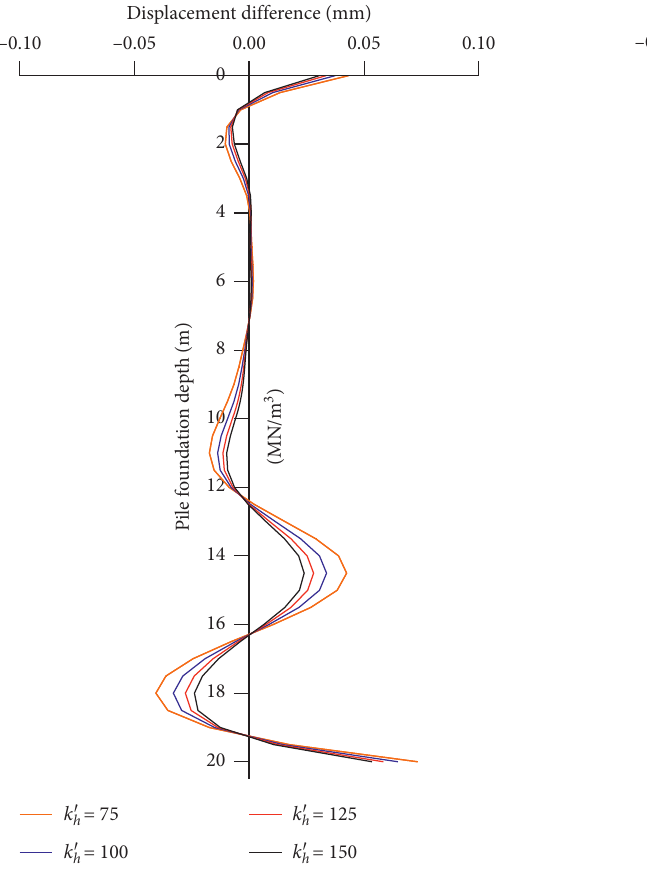
Figure 11: Relation between k